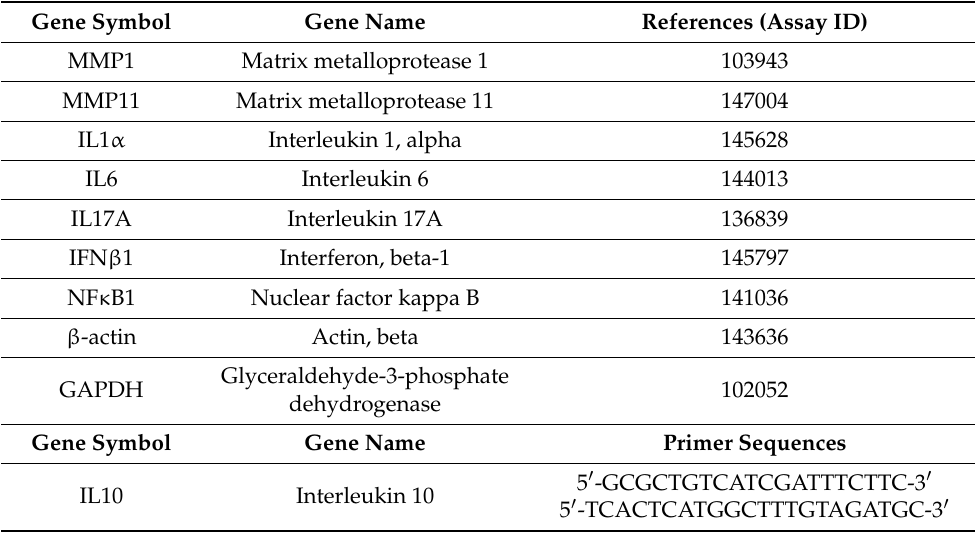
Table 4. RealTime ready Custom Single